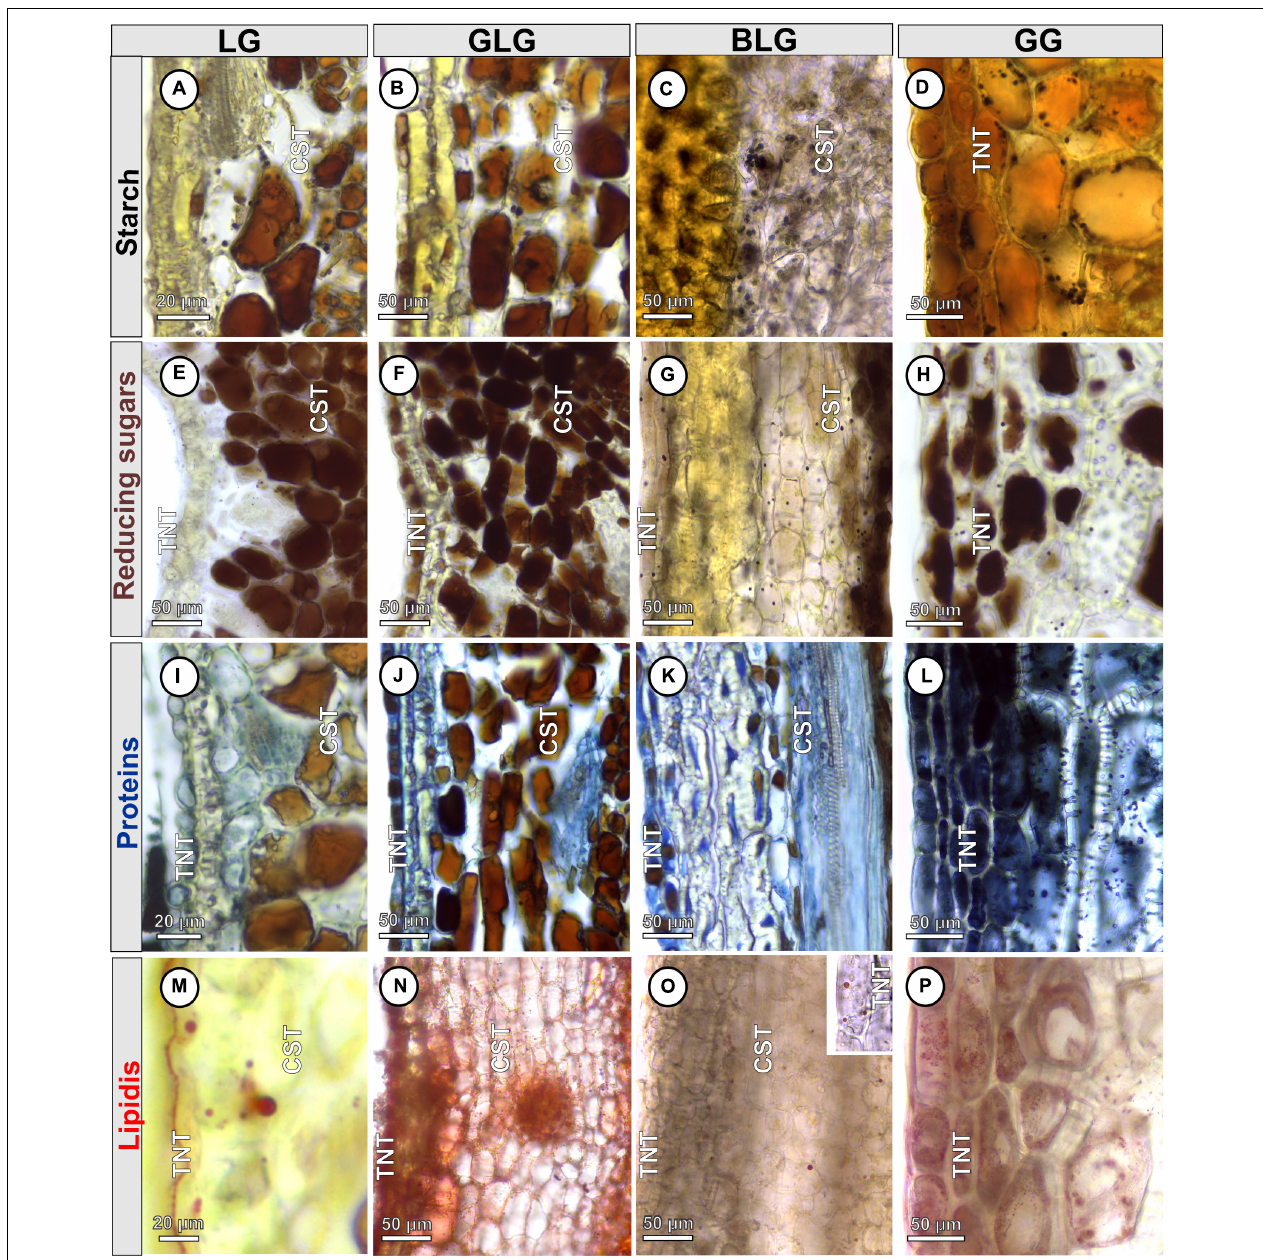
FIGURE 4 | Histochemical profiles of the four Lopesia galls on Mimosa gemmulata Barneby (Fabaceae) pinna-rachis in transverse sections. (A–D) Starch grains stained in black. (E–H) Reducing sugars stained in brown. (I–L) Proteins stained in blue (M–P) Lipidic droplets stained in red. BLG, brown lanceolate bivalve-shaped gall; CST, common storage tissue; GG, globoid bivalve-shaped gall; GLG, green lanceolate bivalve-shaped gall; LG, lenticular bivalve-shaped gall; TNT, typical nutritive tissue.